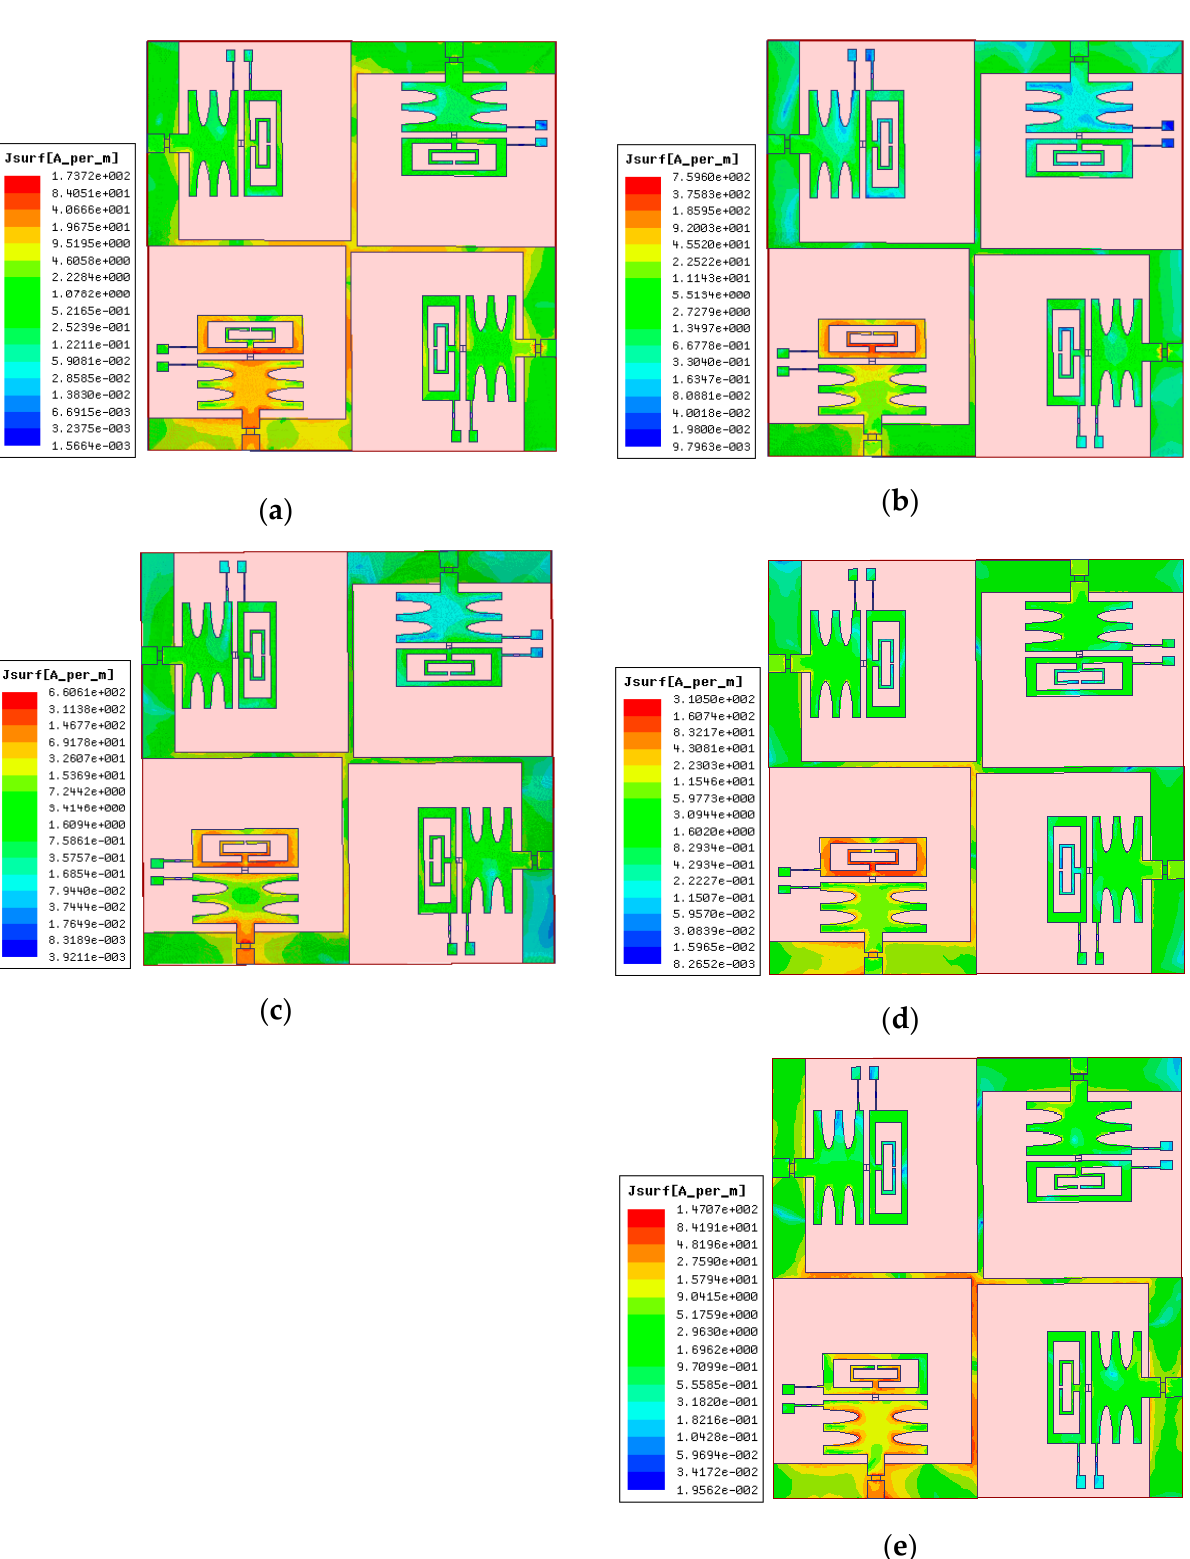
Figure 7. Simulated current flow for modes-1 and -2: ( a ) 2.50 GHz/mode-1; ( b ) 3.50 GHz/mode-1; ( c ) 5.20 GHz/mode-1; ( d ) 3.30 GHz/mode-2; ( e ) 4.70 GHz/mode-2.